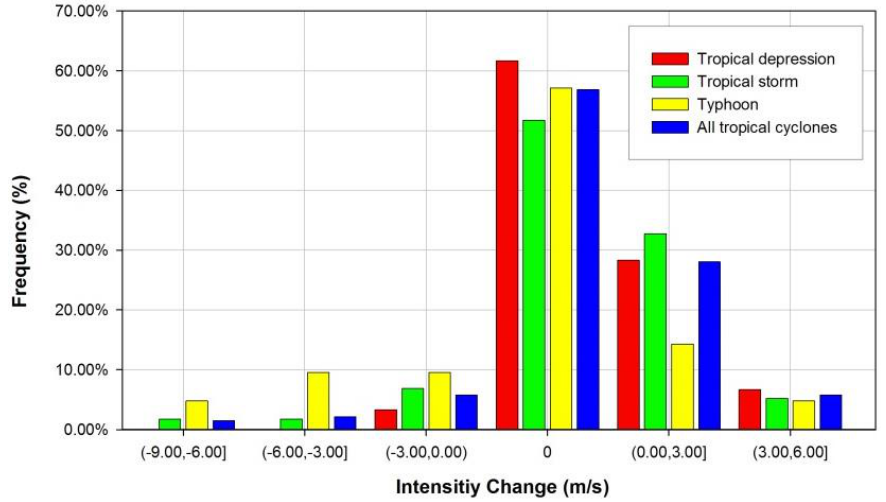
Figure 7. The frequency of TCs in different categories that show no change, an intensifying change, and a weakening change in intensity. Table 4. T -test results for changes in TC intensity.